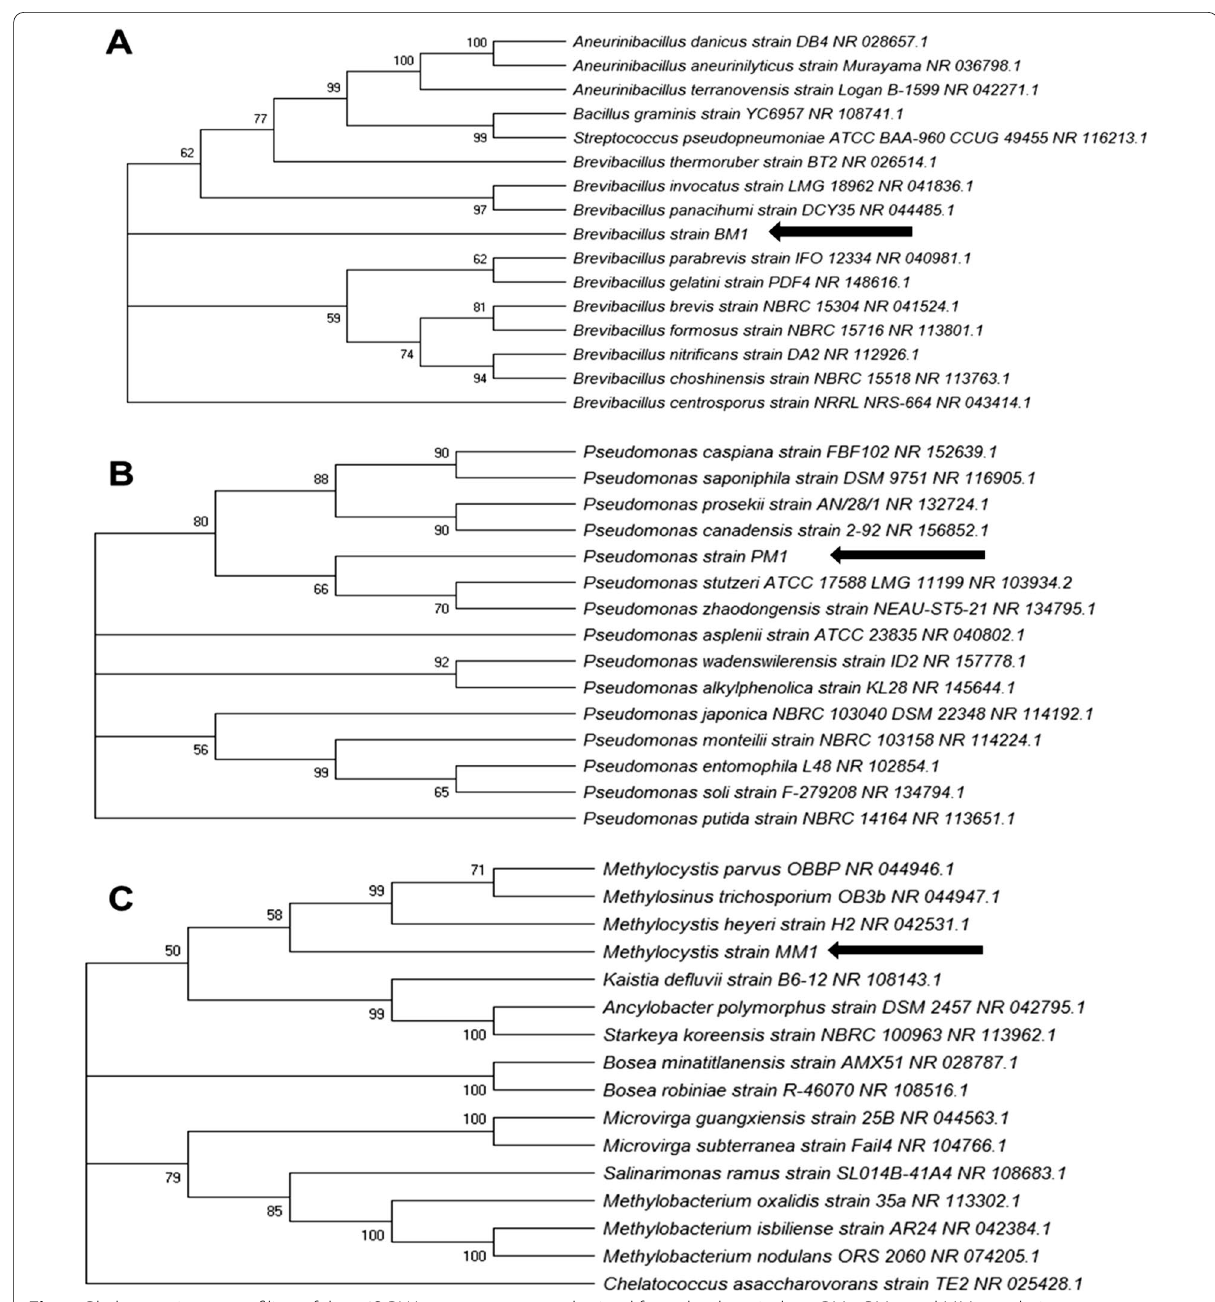
Fig. 1 Phylogenetic tree profiling of the 16SrRNA gene sequences obtained from the three isolates BM1, PM1, and MM1, to their nearest sequences. a Brevibacillus sp. b Pseudomonas sp. c Methylocystis sp. The Phylogenetic tree was built by neighbor-joining [39] with retrieved sequences from the NCBI database bootstrap consensus way with 100 repetitions [40] using MEGA X across computing platforms. The evolutionary distances were computed by the Maximum Composite Likelihood method [48]. This analysis involved 15–16 nucleotide sequences. Evolutionary analyses were conducted in MEGA X